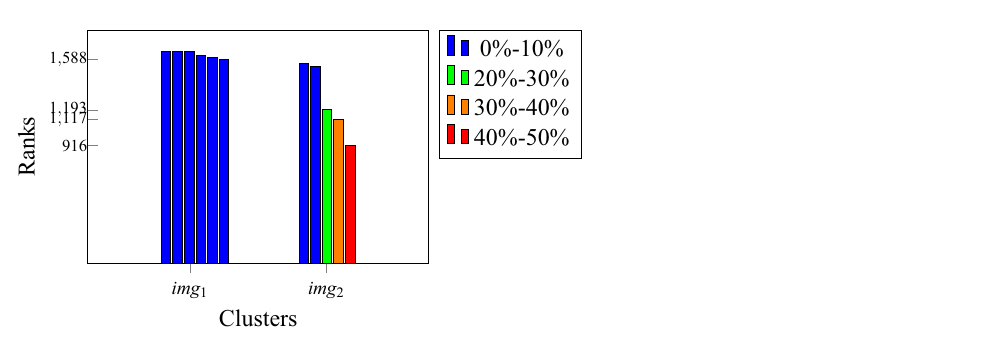
Figure 18. Anomaly detection pipeline applied on a test sample.